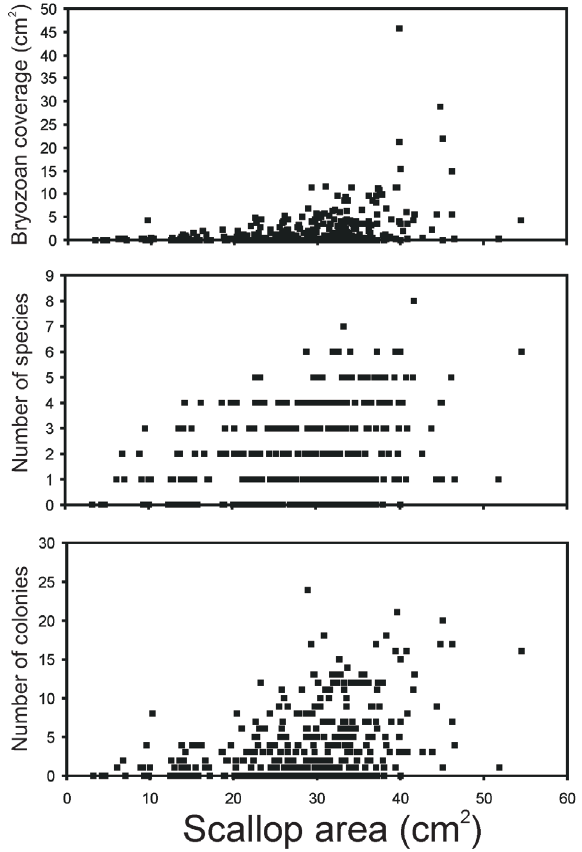
Fig. 4. – Correlations between scallop area and bryozoan coverage, species richness and number of colonies per valve (n =